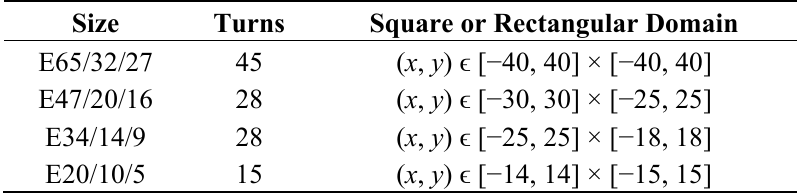
Table 3. Computational domains used for the 2D